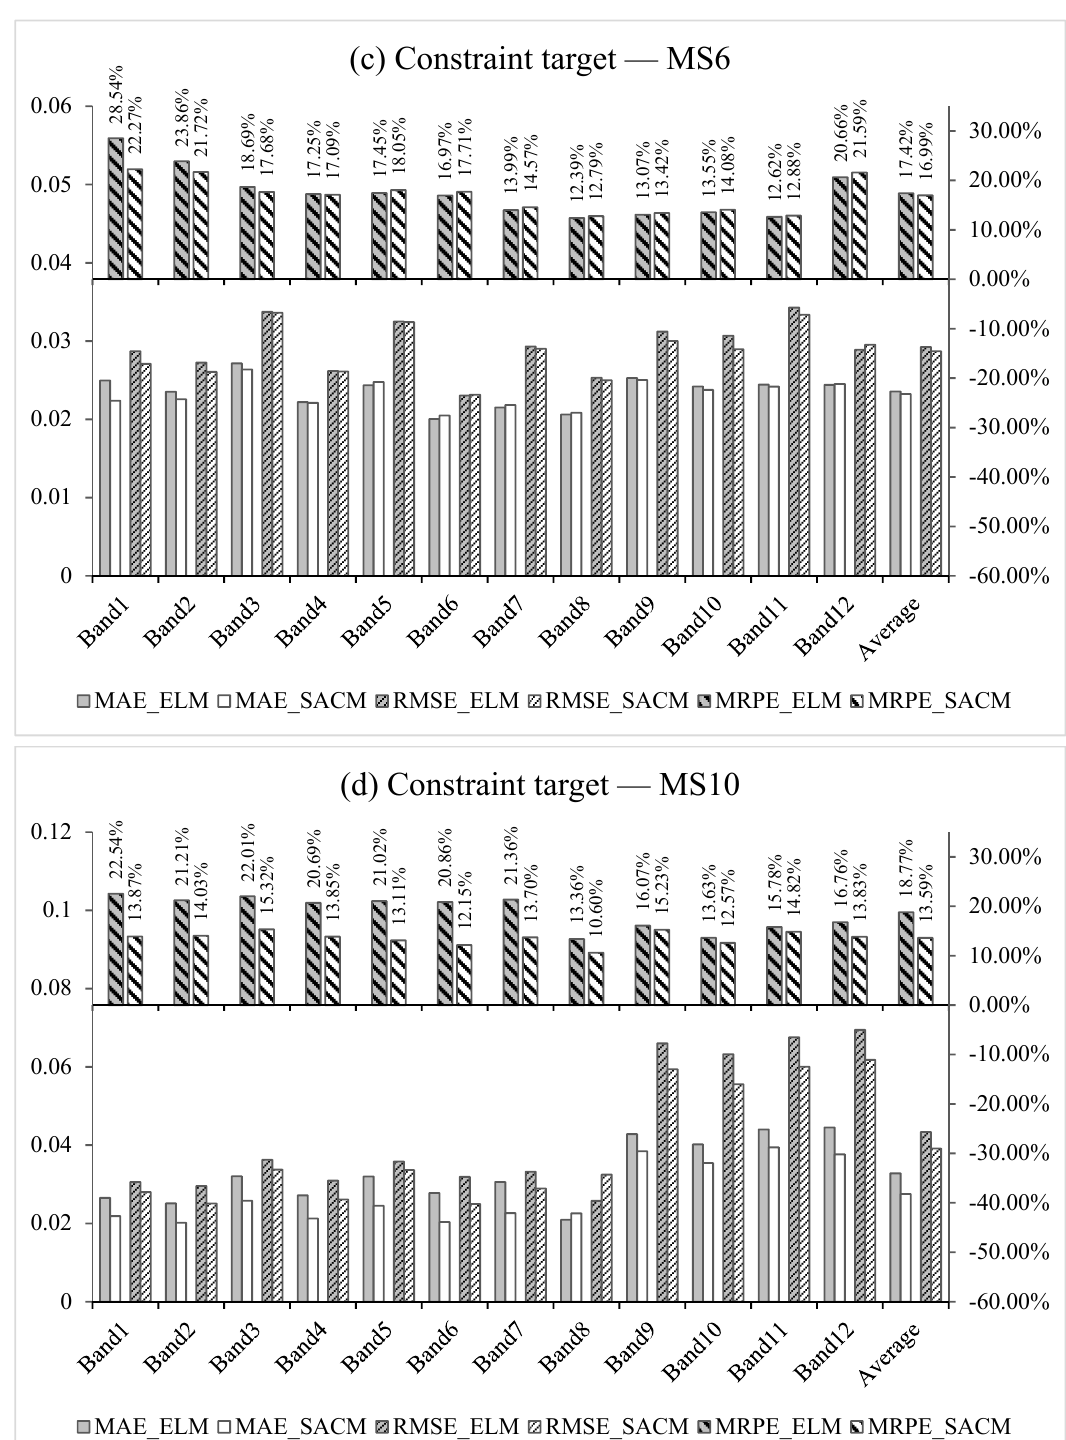
Figure 11. The MAE, MRPE and RMSE of the radiometric calibration using ELM and SACM for different constraint targets of ( a ) MS1 (brick), ( b ) MS3 (water), ( c ) MS6 (floor) and ( d ) MS10 (vegetation). Table 7. The average error of MAE, MRPE and RMSE for different constraint targets.